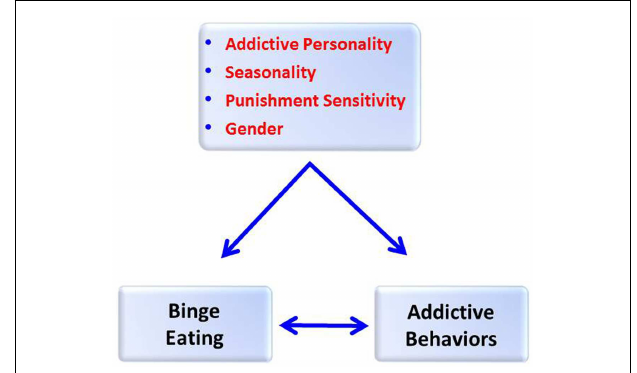
FIGURE 1 |A model predicting that addictive personality traits, seasonality, punishment sensitivity, and gender will be positively associated with a quantitative measure of binge eating and a frequency measure of addictive behaviors, and that binge eating and addictive behaviors will also be positively correlated